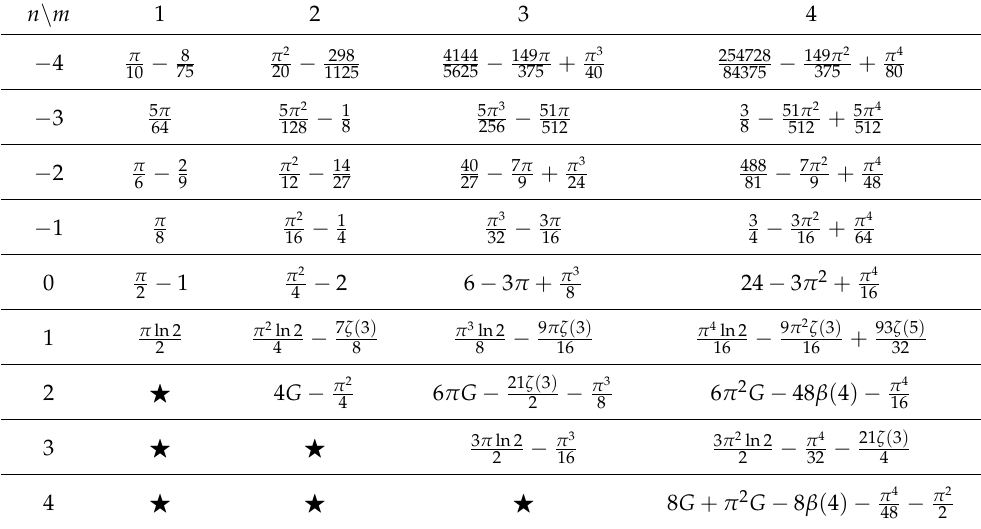
Table 3. Values for S ( m , n )